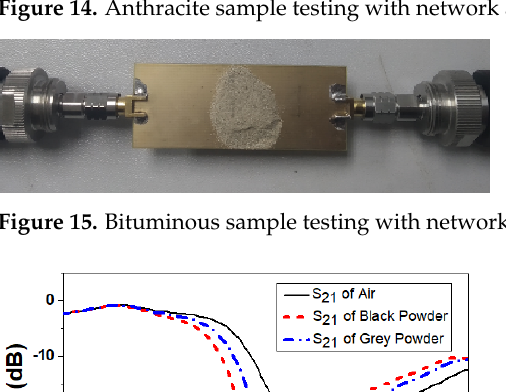
Figure 14. Anthracite sample testing with network analyser.